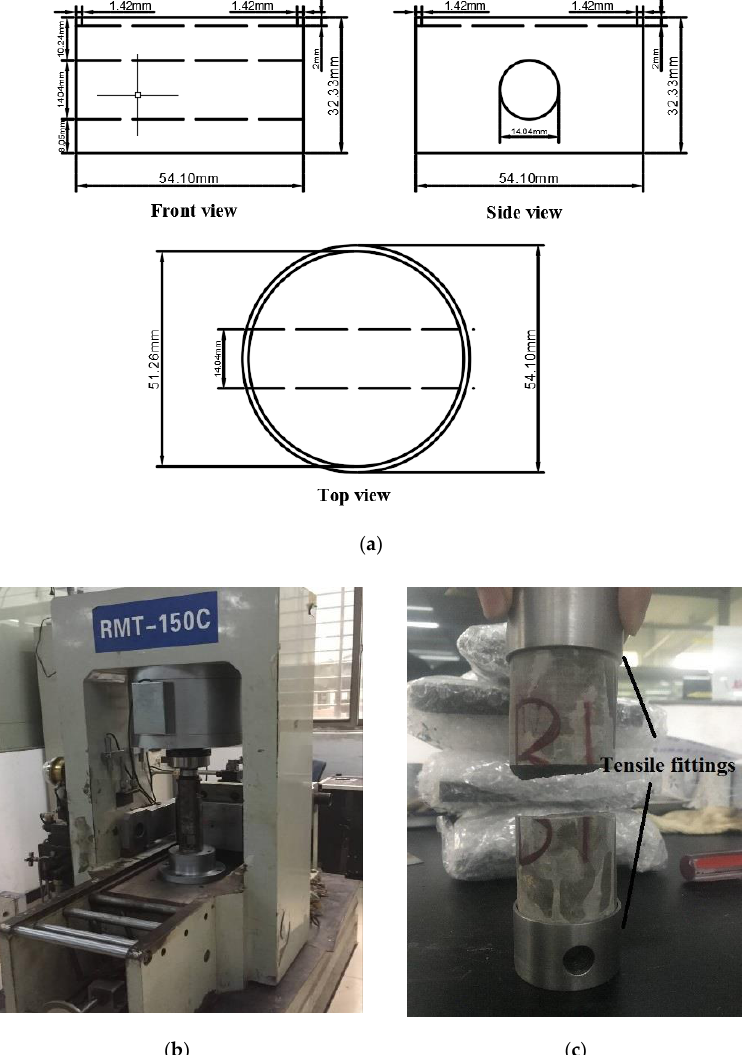
Figure 4. Tensile test on grouting rock fracture; ( a ) three views of tensile fittings, ( b ) tensile test being performed, and ( c ) tensile failure of specimen .